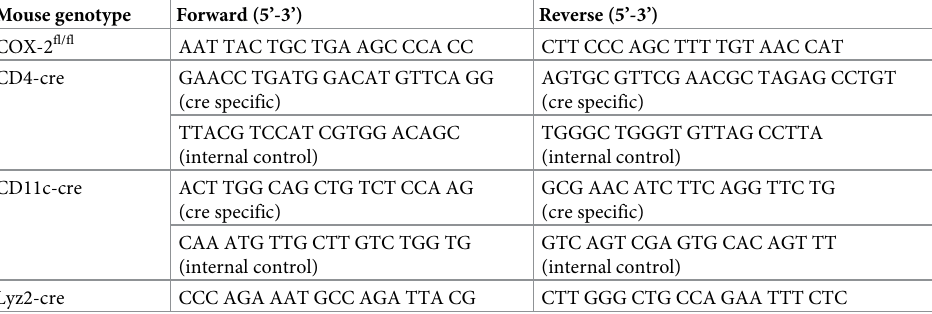
Table 1. Genotyping